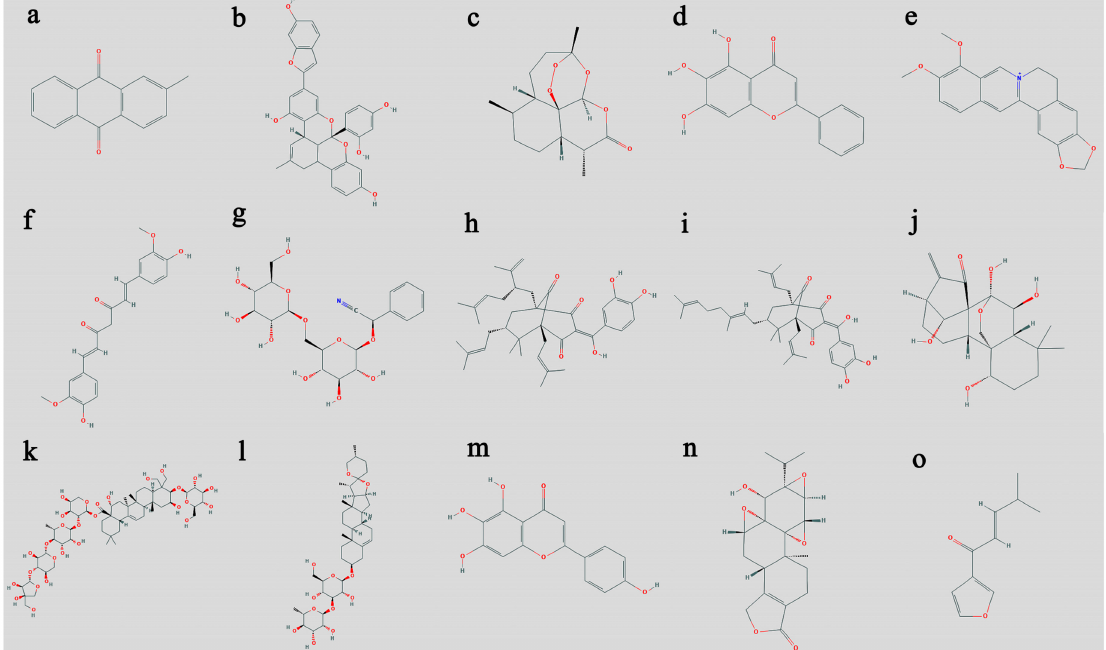
Figure 1. Structural representation of important anticancer secondary metabolites from plants. ThestructuresareadaptedfromNCBIcitedasNationalCenterforBiotechnologyInformation.